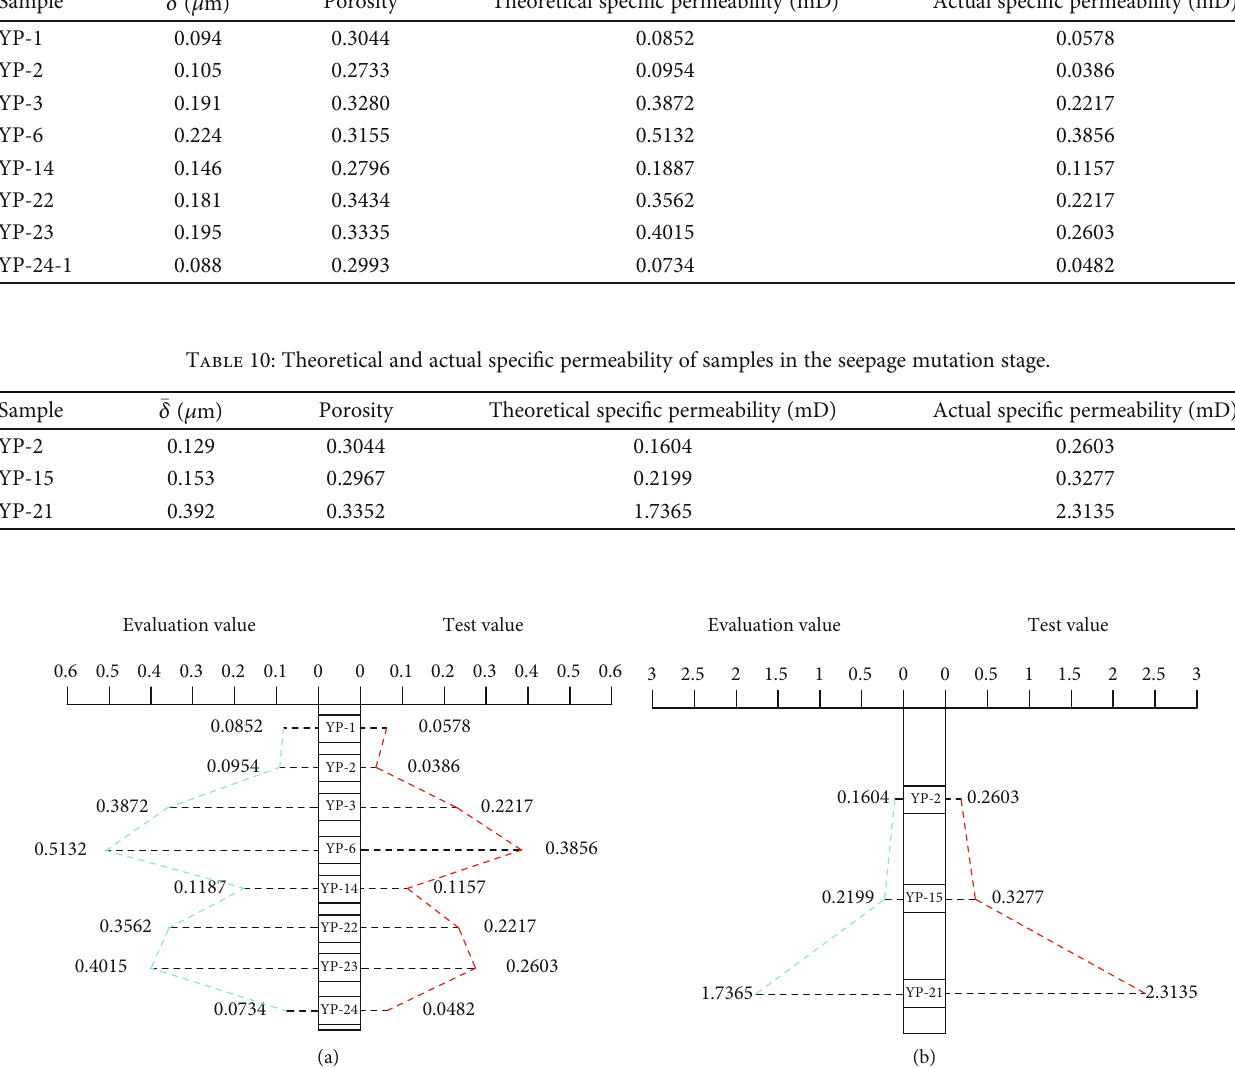
Table 9: Theoretical and actual speci fi c permeability of samples in the stable stage of experiments. Sample